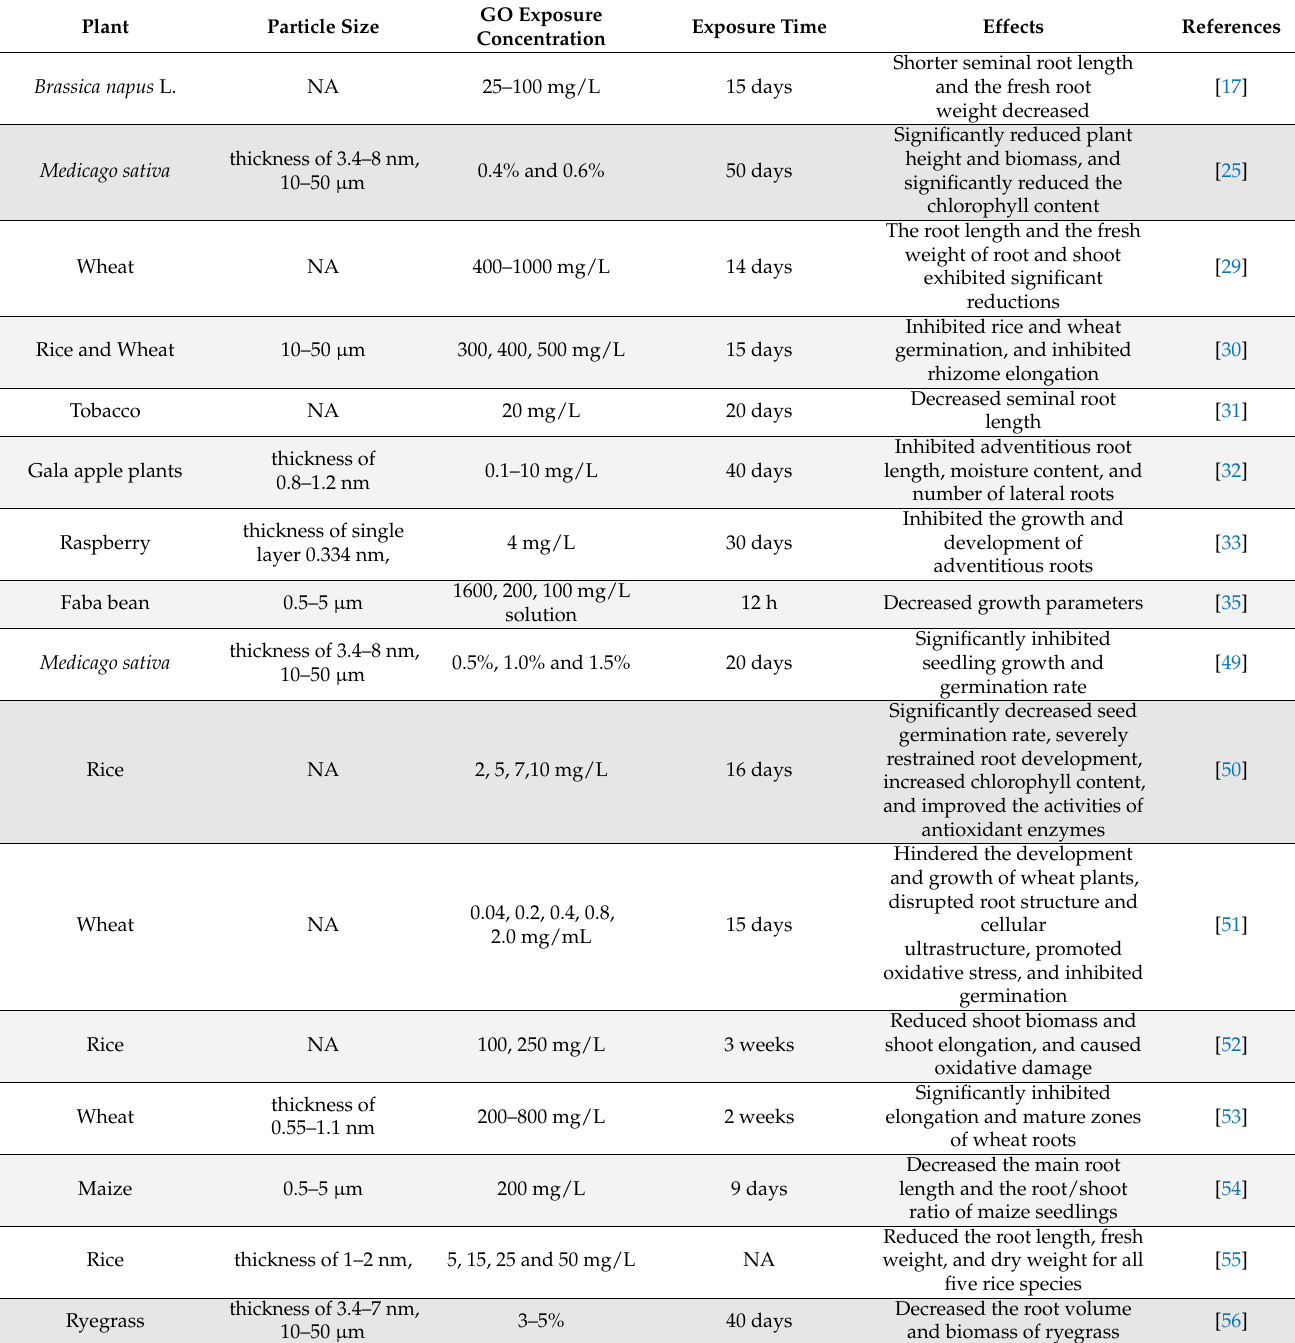
Table 2. Adverse effects of GO on plant